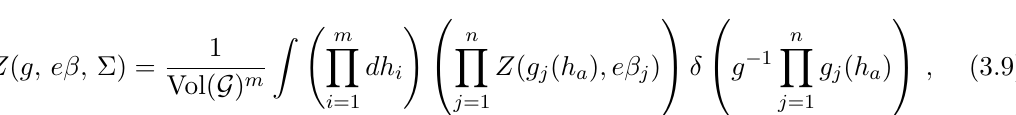
, g 2 = h 3 h 4 h (cid:0) 1 3 5